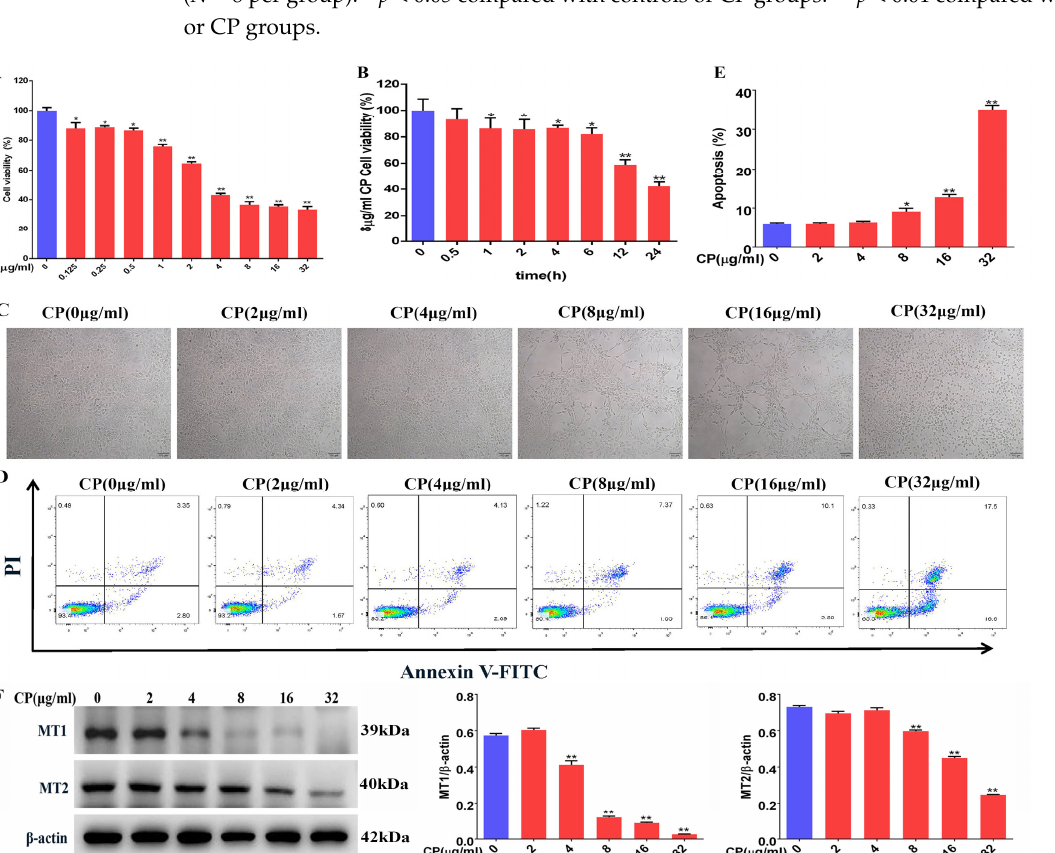
Figure 8. Cisplatin increased apoptosis and downregulated the MT1, MT2, and SIRT1/Nrf2 signal- ing pathways in Leydig cells. ( A ) CCK8 was used to determine the relative cell survival of Leydig cells after treatment with various doses of cisplatin for 24 h. ( B ) CCK8 was used to determine the relative cell viability of Leydig cells treated with 8 μ g/mL of cisplatin for different lengths of time.